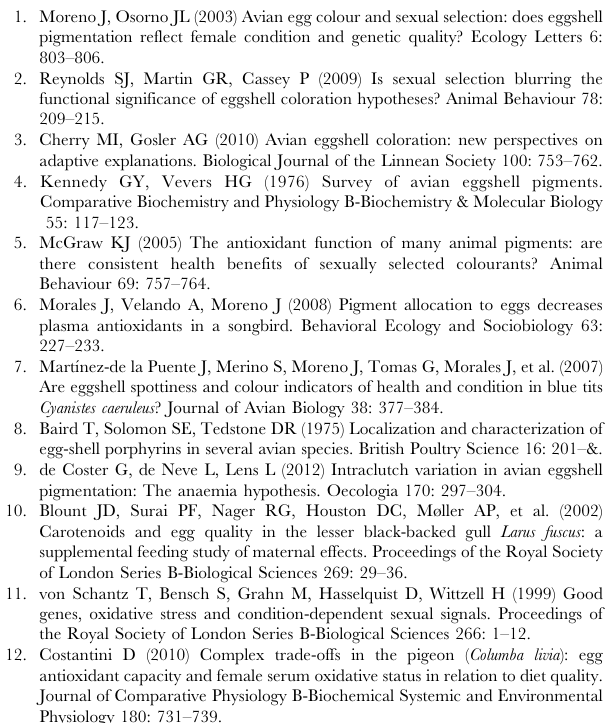
Table S1 Relationships between indicator traits of female, male, and offspring quality and the different eggshell-color traits measured in studies investigating